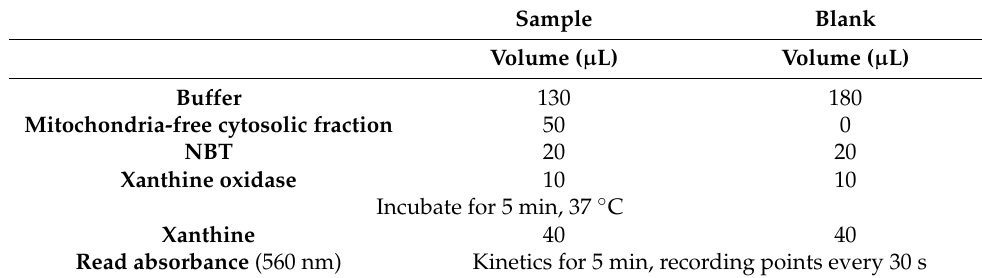
Table 1. Conditions and flow setup for Cu/Zn-SOD activity assay.